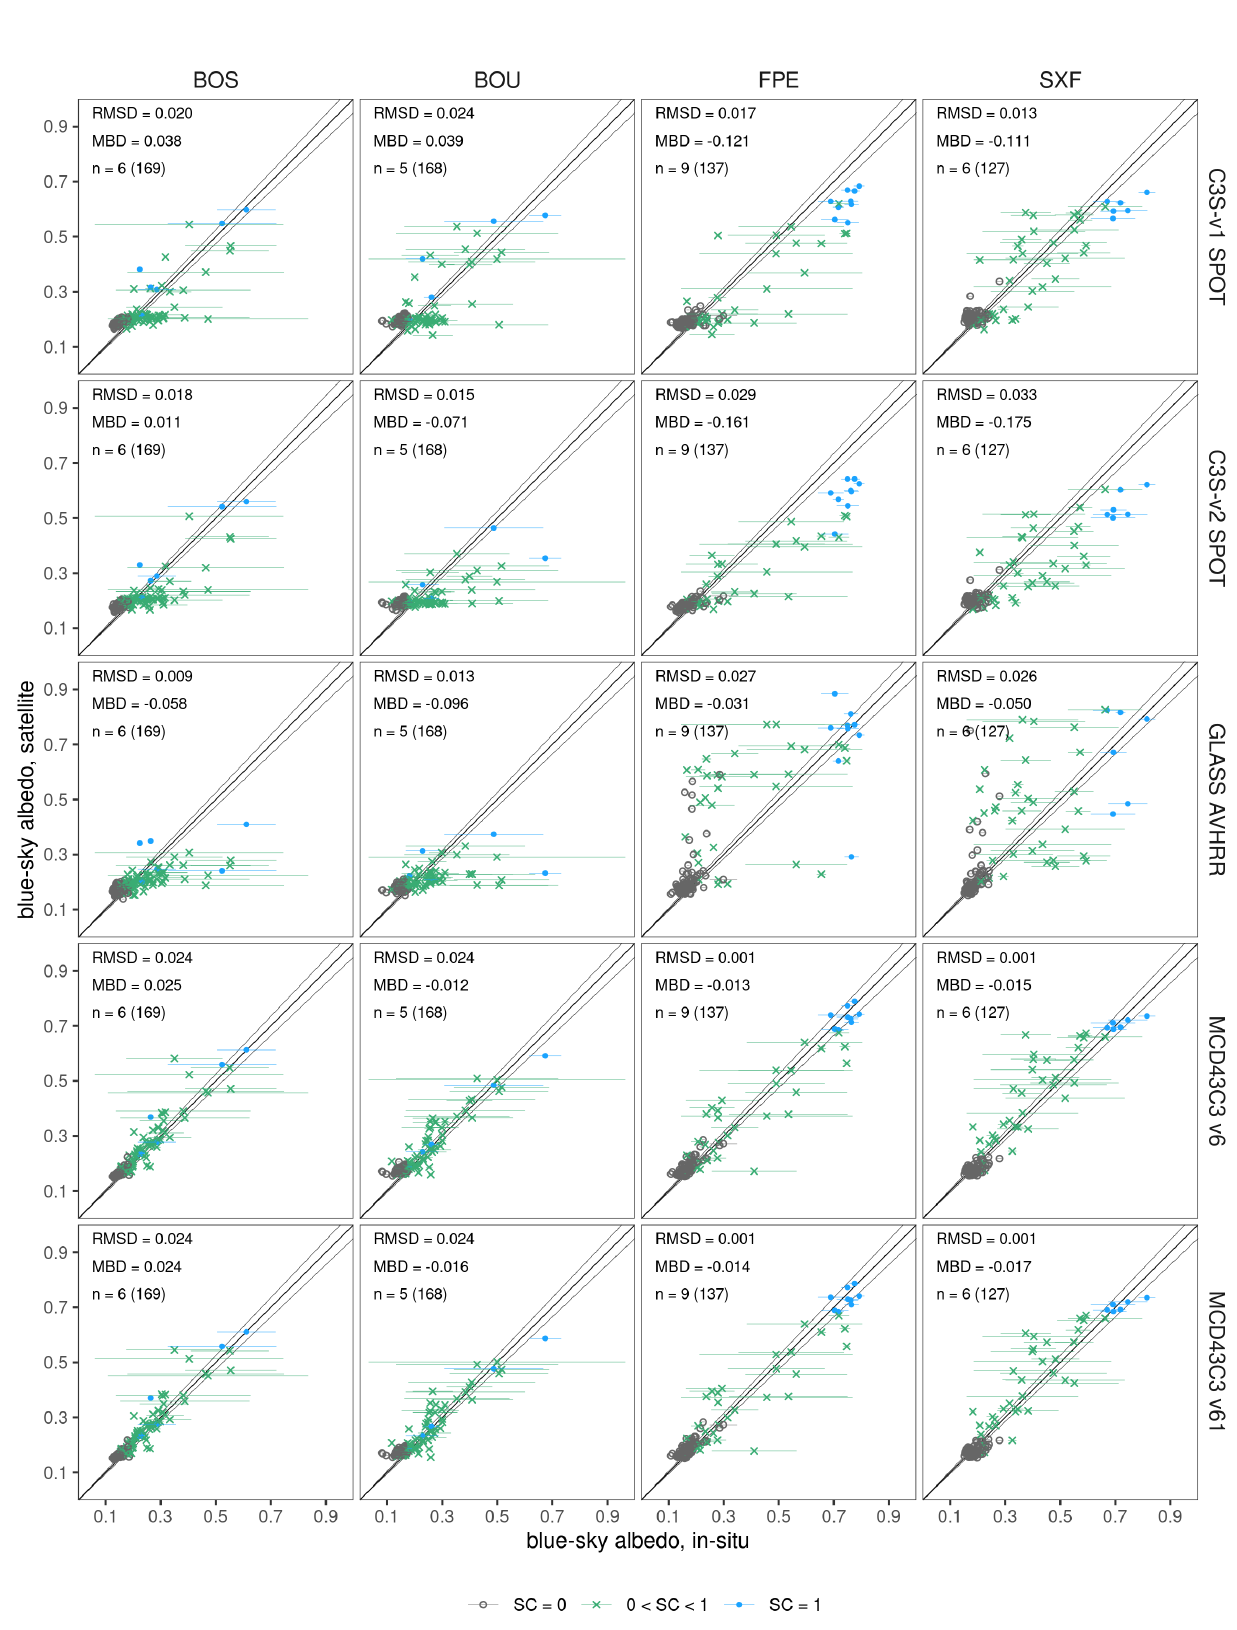
Figure 5. Same as Figure 3 but for BSRN stations (excluding Antarctic